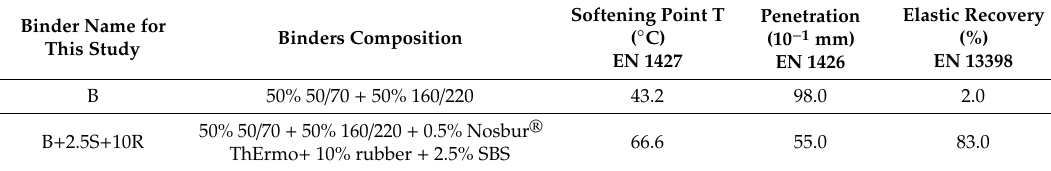
Table 2. Binders name, composition and basic characterization.